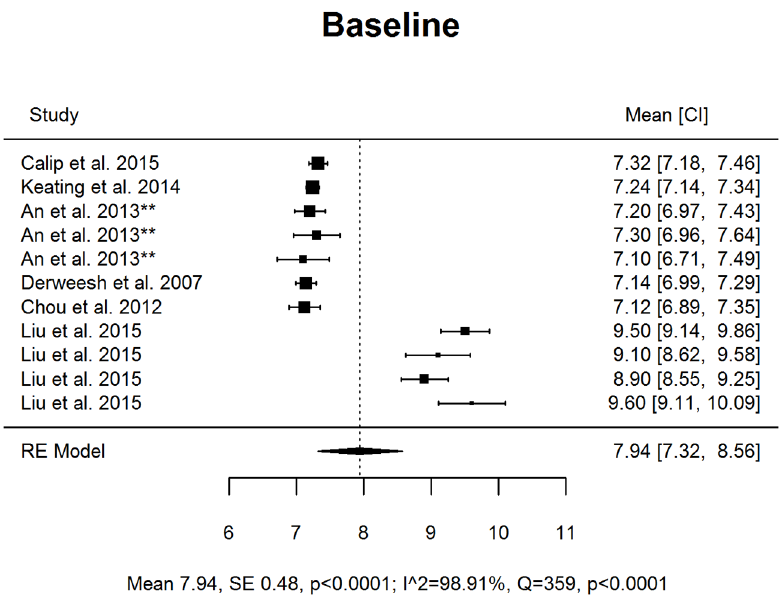
Fig 2. Forest plot of studies considering mean HbA1c levels (%) at time of cancer diagnosis and treatment initiation.